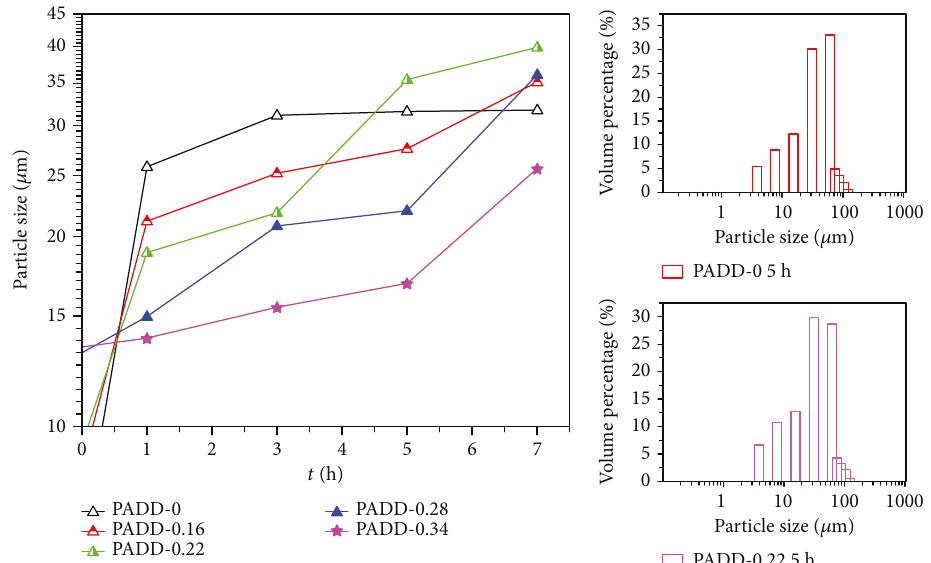
Figure 9: Relationship between particle size and swelling time for MAAE in 10176.6mg/L brine at 25.0 ± 0.1 ° C.